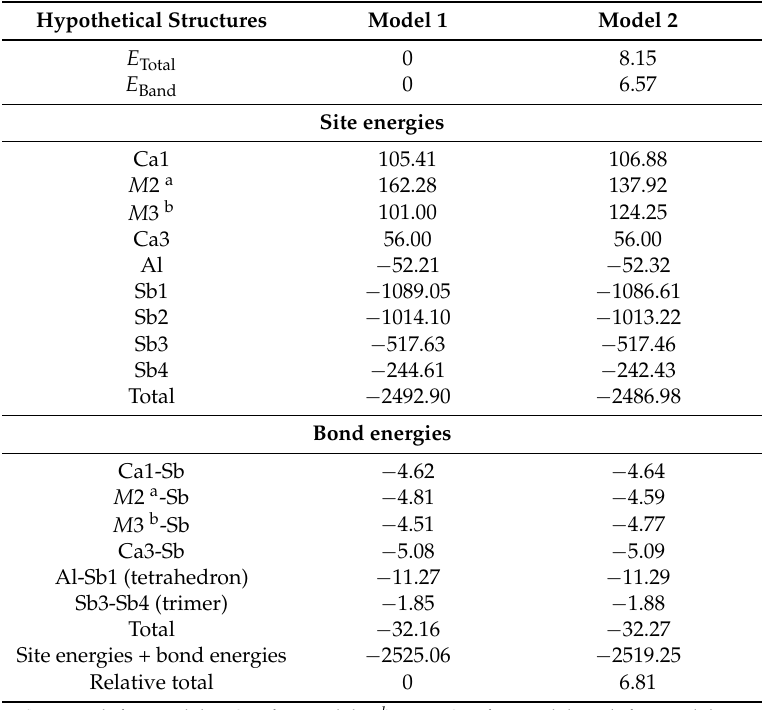
Table 2. Results of tight binding analysis of total energy and band energy (eV) in Model 1 and Model 2 for Yb 4 Ca 10 AlSb 11 .